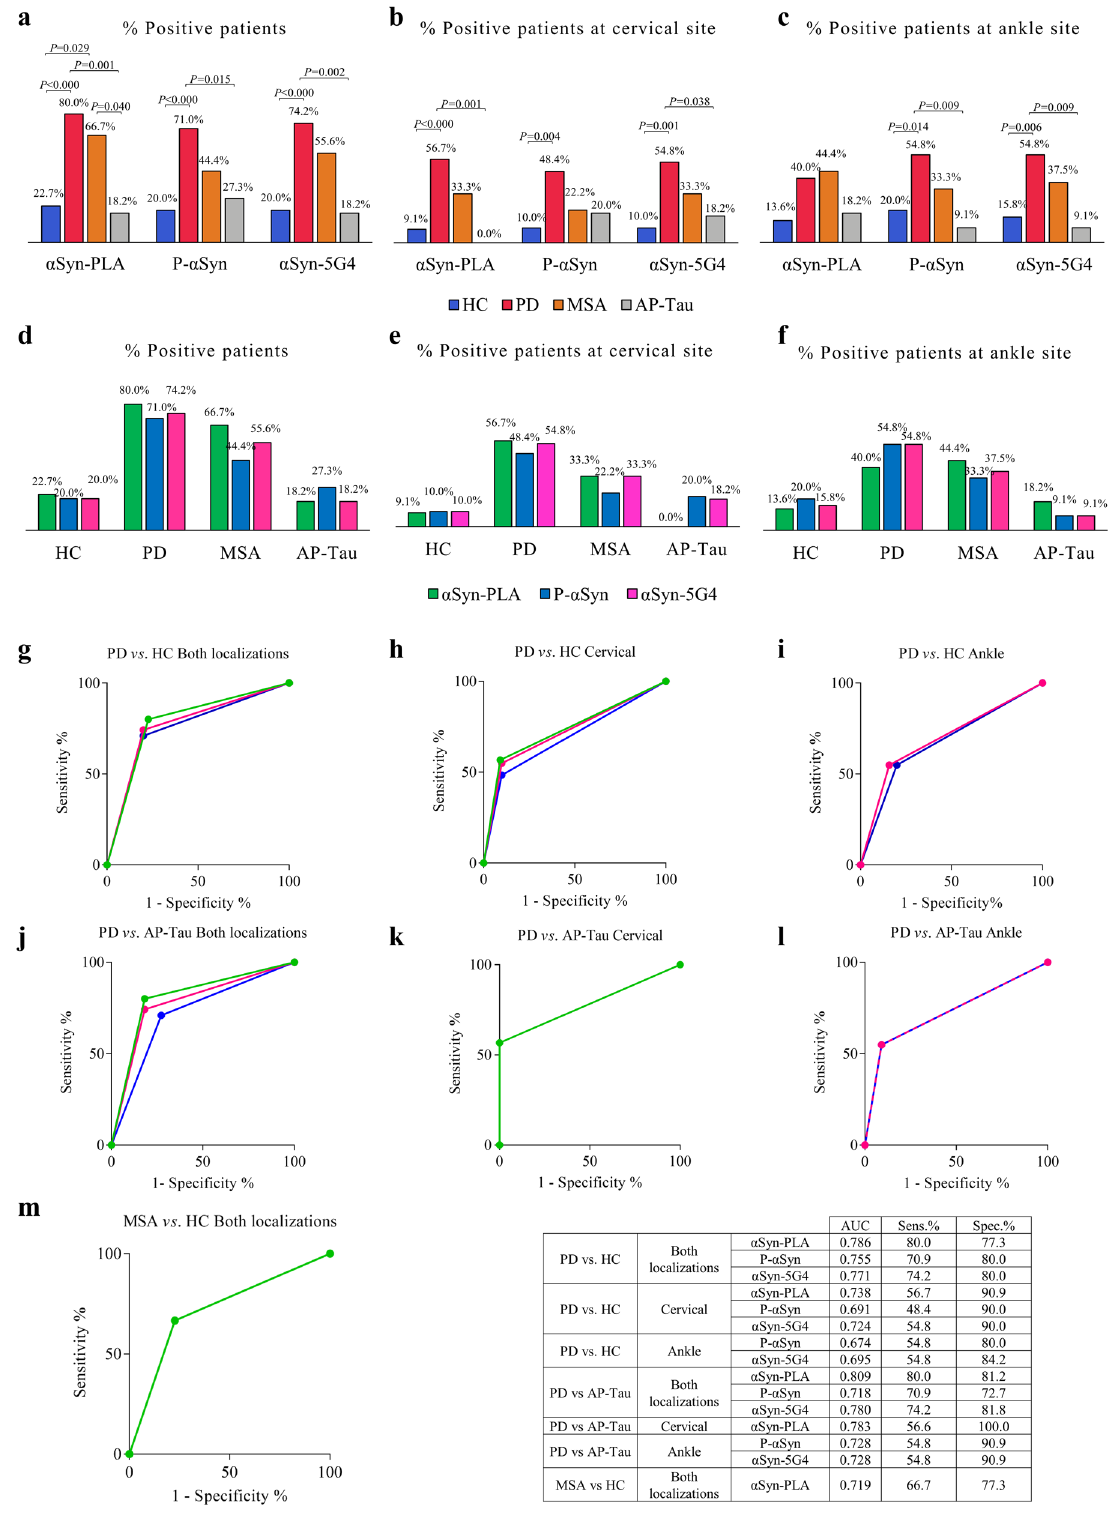
Fig. 4 Comparative analysis and diagnostic performance of α Syn-PLA, P- α Syn, and 5G4. a α Syn-PLA presented the highest sensitivity for PD and MSA at both locations and allowed the differentiation from HC and AP-Tau. b At cervical site α Syn-PLA and α Syn-5G4 showed higher sensitivity than P- α Syn for PD. c In the ankle, P- α Syn and α Syn-5G4 were more sensitive for PD then α Syn -PLA. d – f Within groups no differences were observed between markers, but α Syn-PLA showed a higher sensitivity for MSA than P- α Syn and α Syn-5G4. g – i ROC curve analysis of PD vs. HC, j – l PD vs. AP-Tau, m MSA vs. HC. For each marker and location, AUC, sensitivity, and speci fi city are